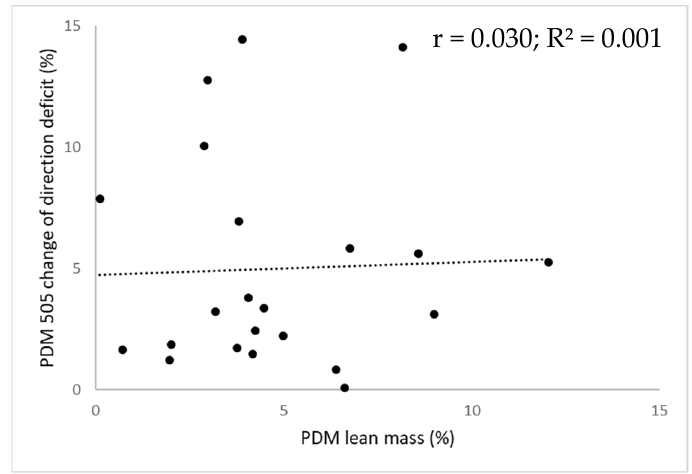
Figure 2. Scatter plot illustrating the relationship between the magnitude of lower extremity lean mass asymmetry (x-axis) and the magnitude of lower extremity functional asymmetry (y-axis) for the high-level female tennis players (N = 22). Note: The dotted line represents the linear trend line; PDM = percentage difference method; r = correlation coefficient; R² = R squared value.